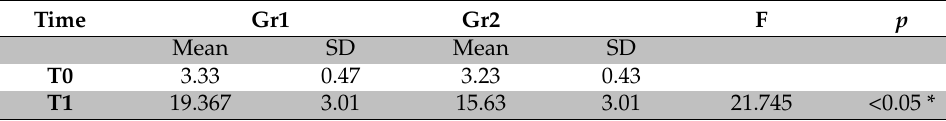
Table 10. Effect of time * group interaction on task 3